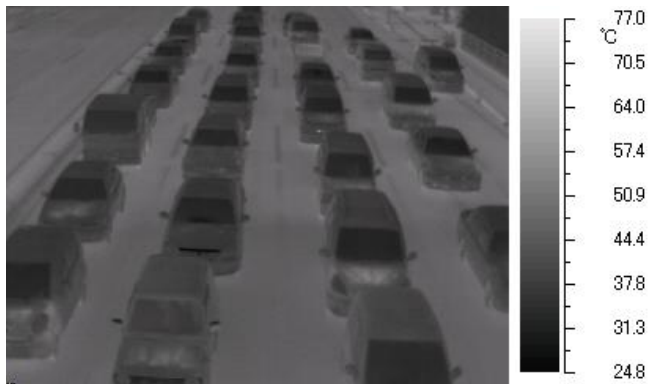
Figure 3. A frame of thermal